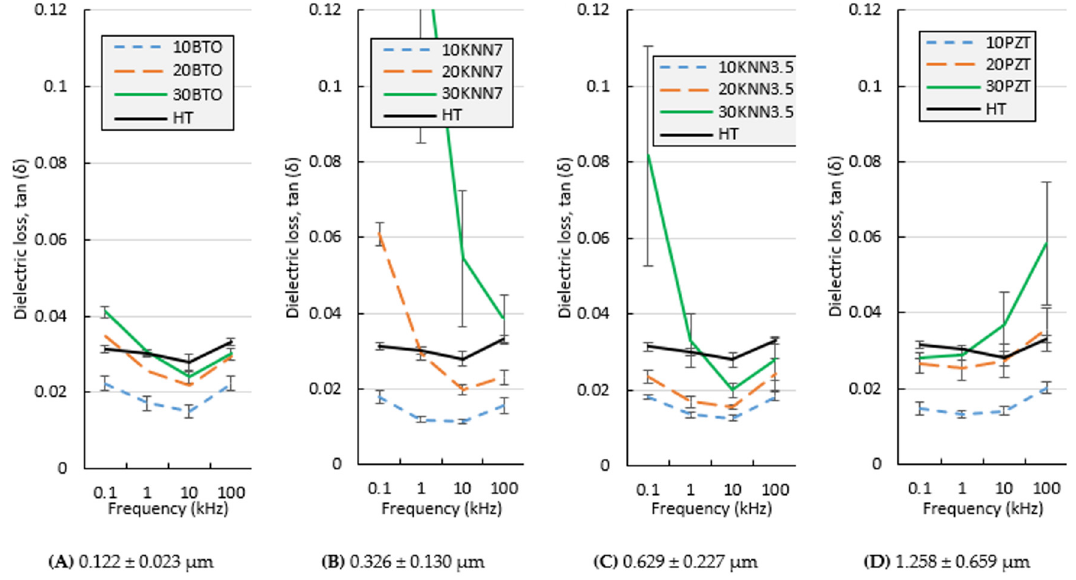
Figure 11. Dielectric loss (dissipation factor tan ( δ )) values at different frequencies at room tempera- ture for piezoelectric composites filled with ( A ) BTO, ( B ) KNN7, ( C ) KNN3.5, or ( D )